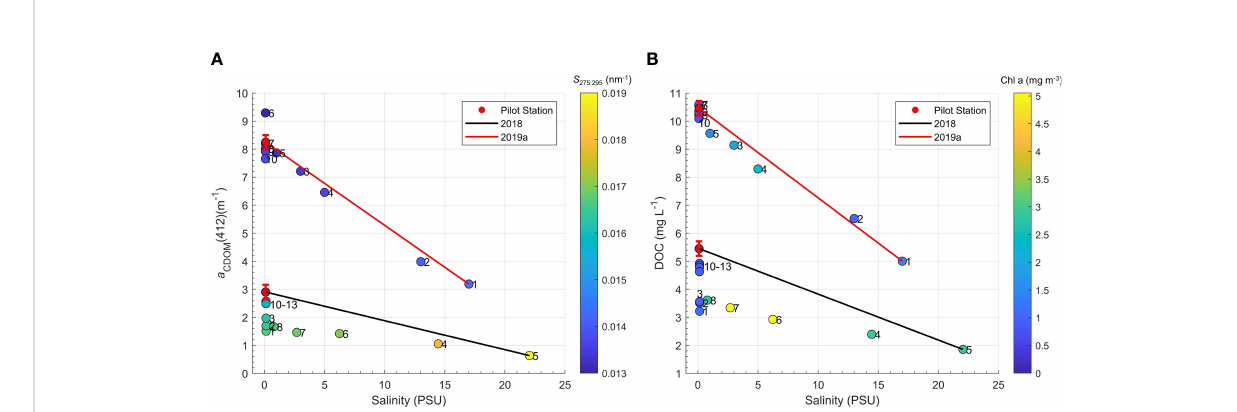
FIGURE 8 (A) Salinity regressed against a CDOM (412)(m -1 ) for the offshore transects carried out in 2018 and 2019 where the color of the marker is represented by the value of the spectral slope coef fi cient calculated between 275-295 (nm -1 ). The red and black lines represent the hypothetical mixing lines between the saltwater endmember and modeled a CDOM (412)(m -1 ) at Pilot Station. The standard error bars for the modeled results at Pilot station are shown in red. The percent error from a CDOM (412)(m -1 ) replicates from this study were typically less than 1% and not shown on this fi gure. (B) Salinity regressed against DOC concentration (mg C L -1 ) for the offshore transects carried out in 2018 and 2019 where the color of the marker is represented by chlorophyll- a concentration (mg m -3 ). The standard error bars for the modeled results at Pilot station are shown in red. The percent error from DOC replicates was typically less than 2.5% and not shown on this fi